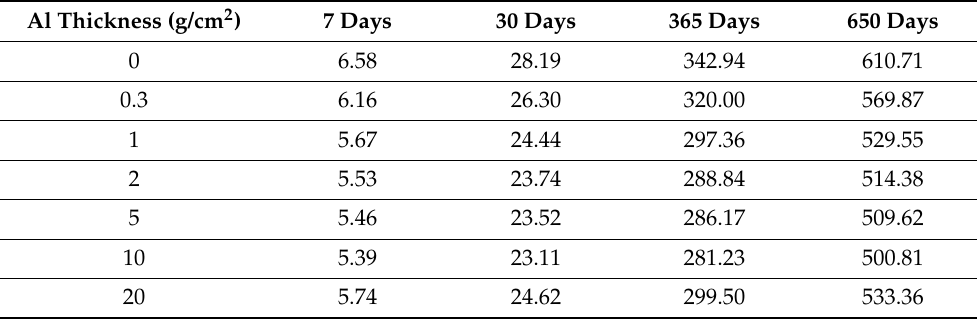
Table 8. Equivalent doses (mGy · RBE M ) at solar minimum calculated by multiplying the absorbed doses by the RBE M value for cell